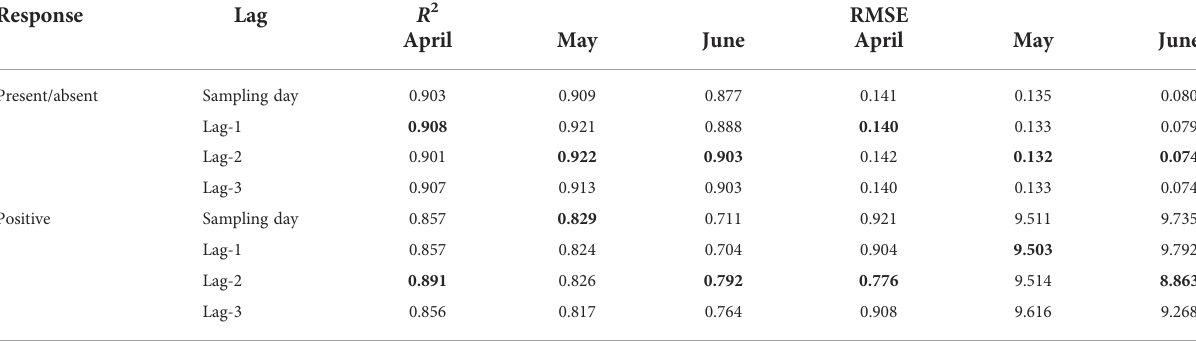
TABLE 3 Model performance evaluations for occupancy and abundance habitat models with a maximum time lag of 3 days based on R 2 and RMSE using RF analyses from April to June.